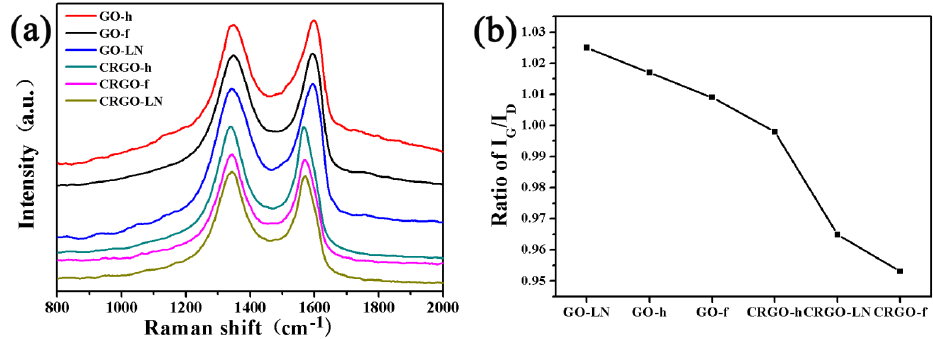
Figure 3. ( a ) Raman spectra of GO and CRGO films; ( b ) I G / I D ratios of GO and CRGO films.